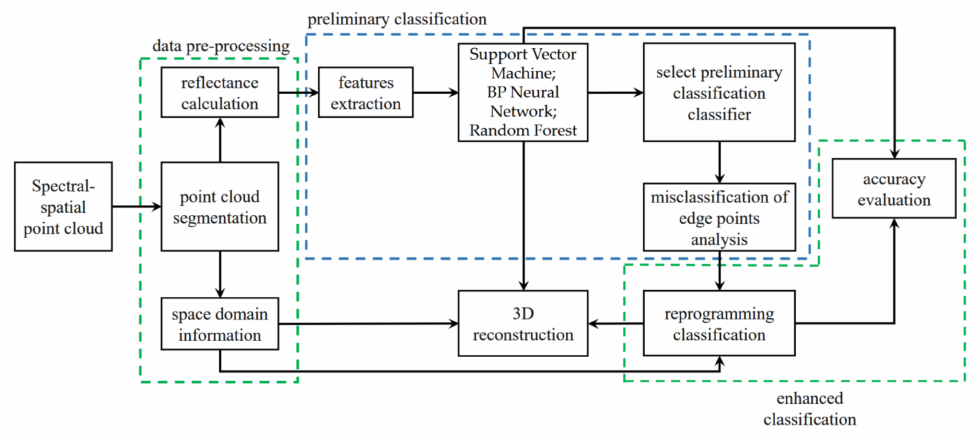
Figure 4. Structure diagram of tree components’ classification and 3D